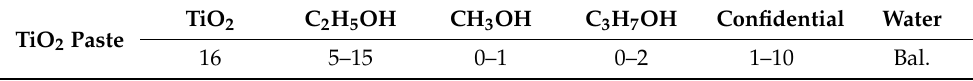
Table 4. Composition of TiO 2 paste (weight